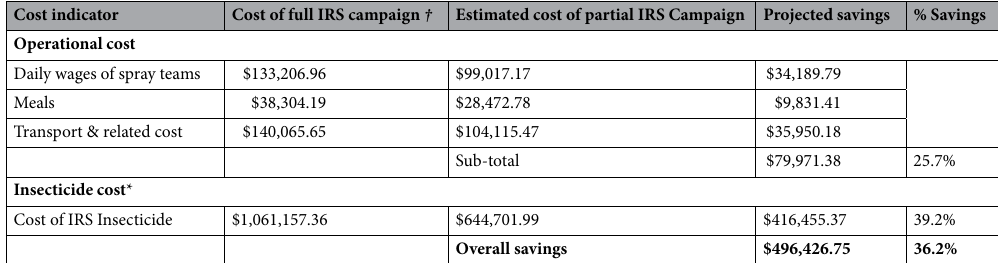
Table 2. Estimated savings on direct IRS operational expenses and insecticide costs based on a 30-day full IRS campaign and a 22.3-day partial IRS campaign based on the 2018 PMI VectorLink Ghana IRS campaign. * Cost of Actellic CS, 30% a.i., Syngenta used for this estimation is $16.19 price based on 2018 cost (shipping and insurance inclusive). †Estimated cost is based on 298,701 rooms sprayed and 65,544 Actellic CS, 30% a.i. bottles used during the 2018 IRS (full IRS) campaign.